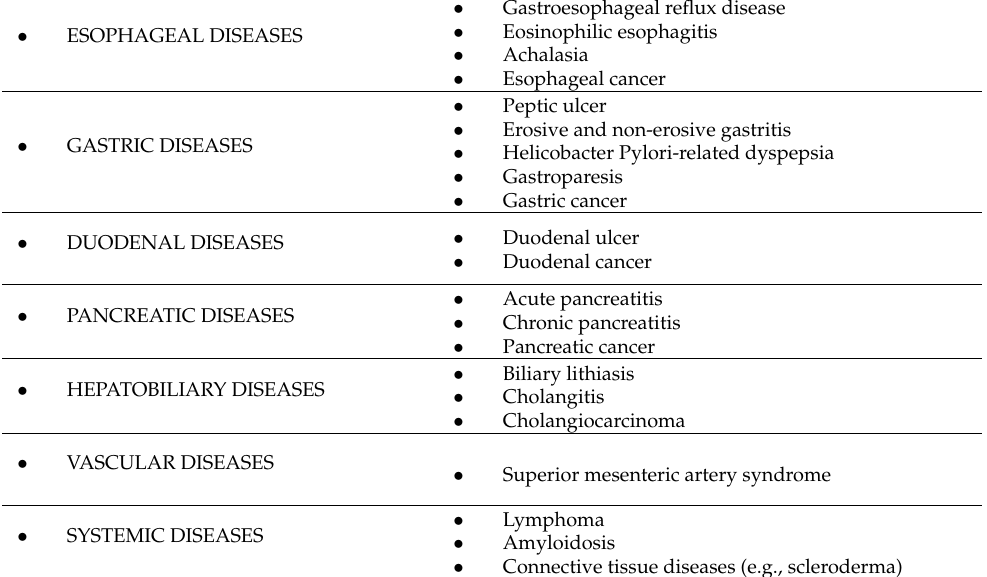
Table 2. Differential diagnoses of